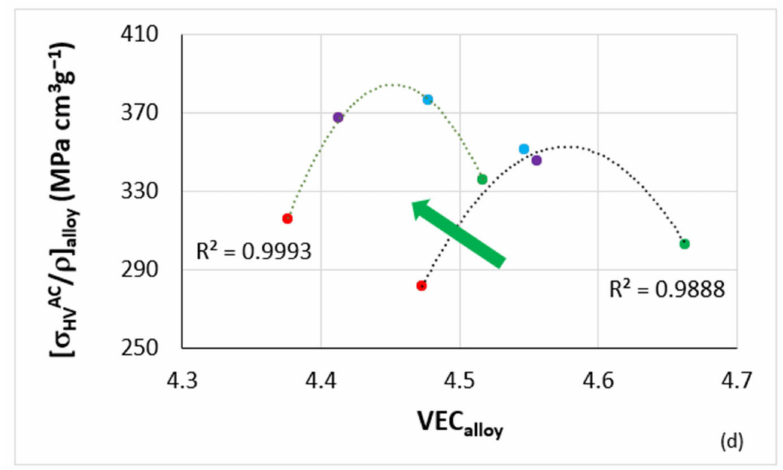
Figure 8. ( a ) to ( c ) Vickers hardness (HV) and ( d ) room temperature specific strength calculated from hardness ( σ HV / ρ ) versus the parameters ( a ), ( d ) VEC, ( b ) δ and ( c ) ∆ χ of the TT2, TT3, TT4, TT8, KZ4, KZ5, KZ7 and JG3 alloys. In ( a ) to ( c ) the data is for the AC and HT conditions and in ( d ) the data is for the AC condition. Filled circles green TT2 and KZ4, red TT3 and KZ7, purple TT4 and KZ5, and blue TT8 and JG3. In ( b ) and ( c ) ellipses enclose the B containing alloys. In ( a ) and ( d ) the R 2 values are for the parabolic fit of data. In ( a ) data for the alloys TT2, TT3, TT4 and TT8 with R 2 = 0.998 and R 2 = 0.9046 for the AC and HT conditions, respectively and with R 2 = 0.9922 and R 2 = 0.9908 respectively for the AC and HT alloys KZ4, KZ5, KZ7 and JG3. In ( d ) R 2 = 0.9993 and R 2 = 0.9888 respective for the AC alloys TT2, TT3, TT4, TT8 and KZ4, KZ5, KZ7, JG3. In ( a ) and ( d ) green arrows indicate the effect of B addition.